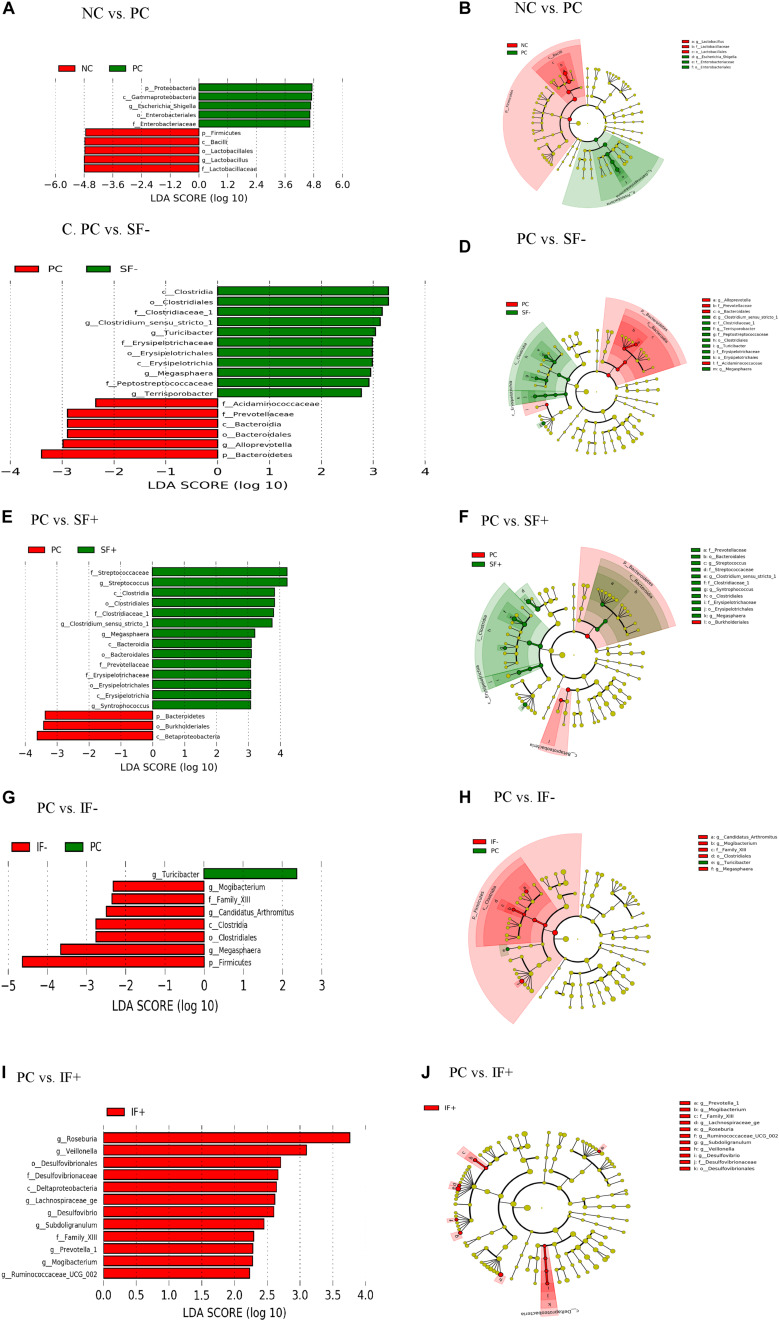
LEfSe reveals predicted biological effect sizes of differential taxa in ileal microbiota of pigs fed control diet without ETEC (NC), control diet with ETEC (PC), soluble fiber diet without (SF-) or with carbohydrases (SF+), or insoluble fiber diet without (IF-) or with carbohydrases (IF+) after an ETEC challenge. Histogram (A,C,E,G,I) of the linear discriminant analysis (LDA) scores computed for features differentially abundant bacteria and Cladogram (B,D,F,H,J) revealing statistically and biologically consistent differences in detected taxa between (A,B) NC and PC; (C,D) PC and SF-; (E,F) PC and SF+; (G,H) PC and IF-; and (I,J) PC and IF+.